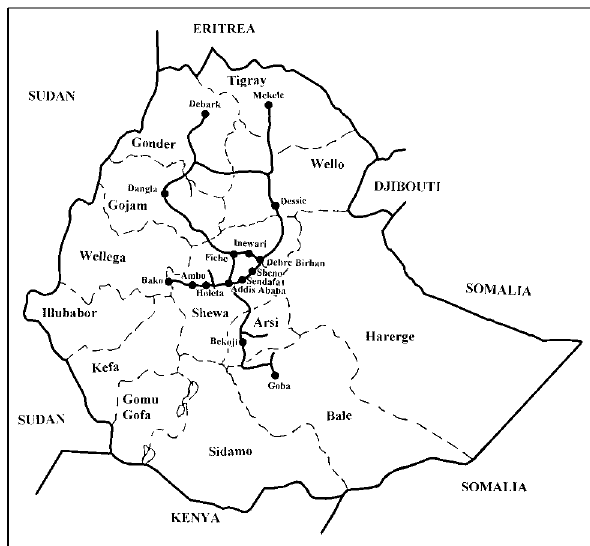
Fig. 1. A map of Ethiopia showing the location of the regions surveyed for faba bean virus diseases. Dotted lines indicate regional boundaries whereas solid lines indicate survey